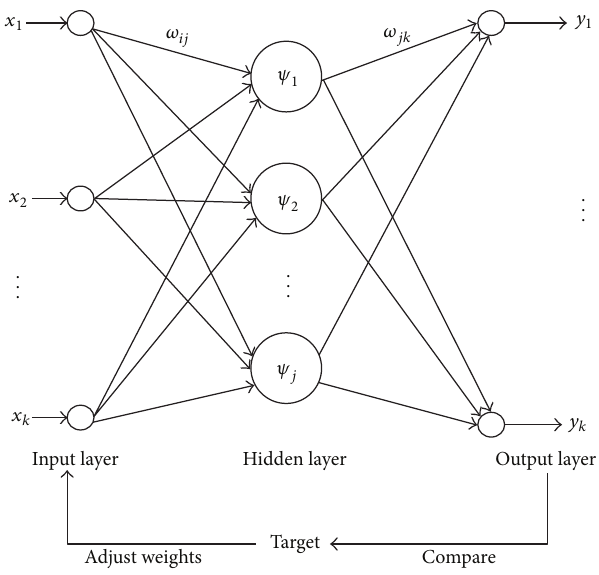
Figure 1: Structure of a wavelet neural